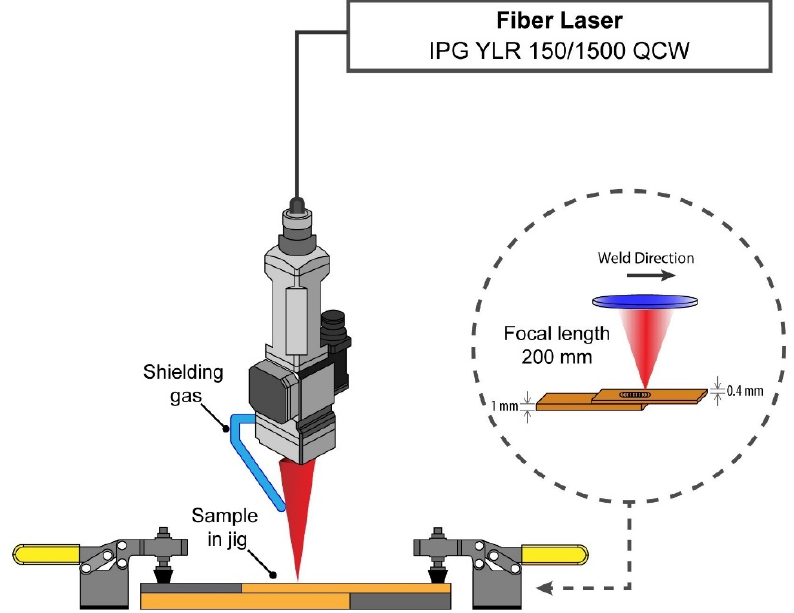
Figure 1. Schematic view of the laser beam welding set-up.